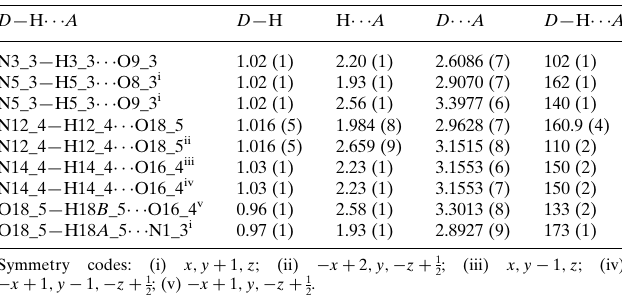
Hydrogen-bond geometry (A˚ , (cid:3)